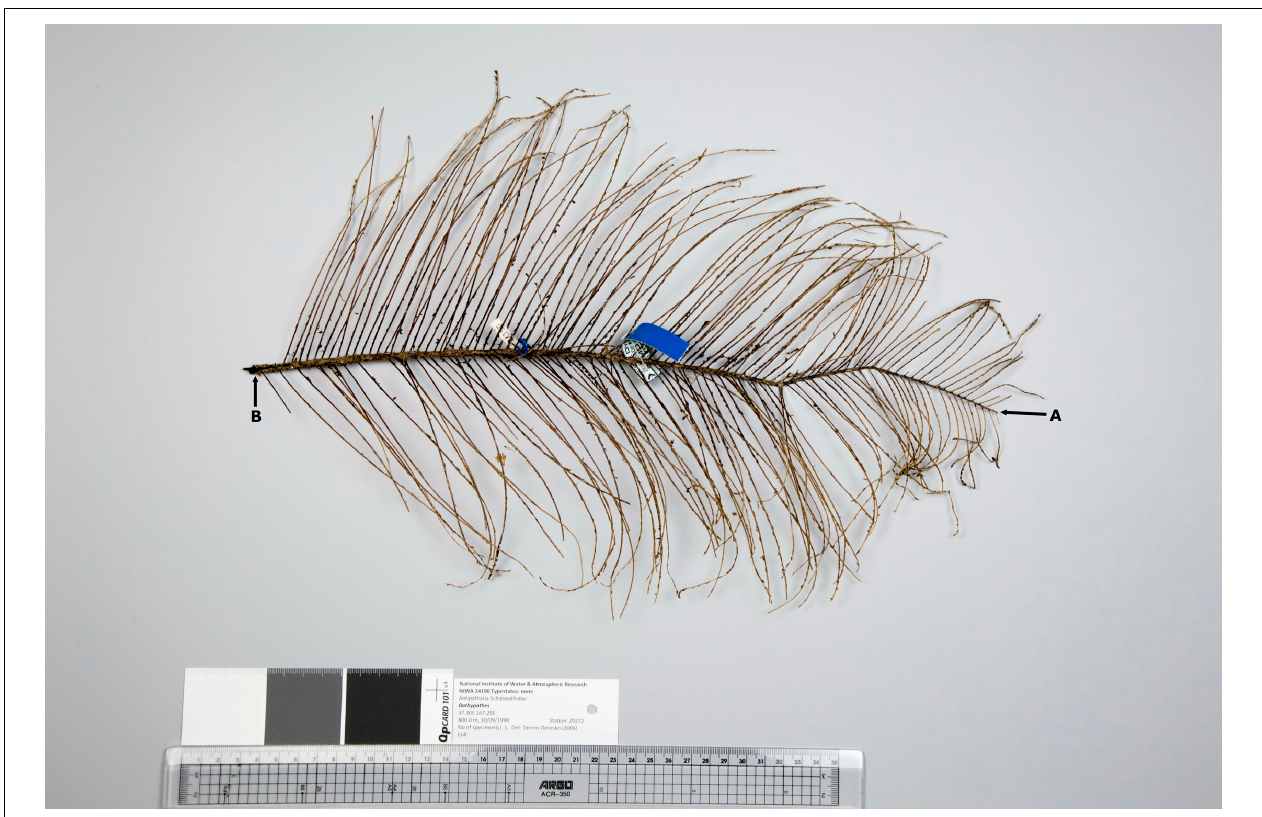
FIGURE 2 | Bathypathes cf. conferta . NIWA24190. Specimen showing where samples were extracted for analysis. (A) is the growing tip, (B) the basal section. Specimen from Bay of Plenty, New Zealand. Scale bar is a 35 cm